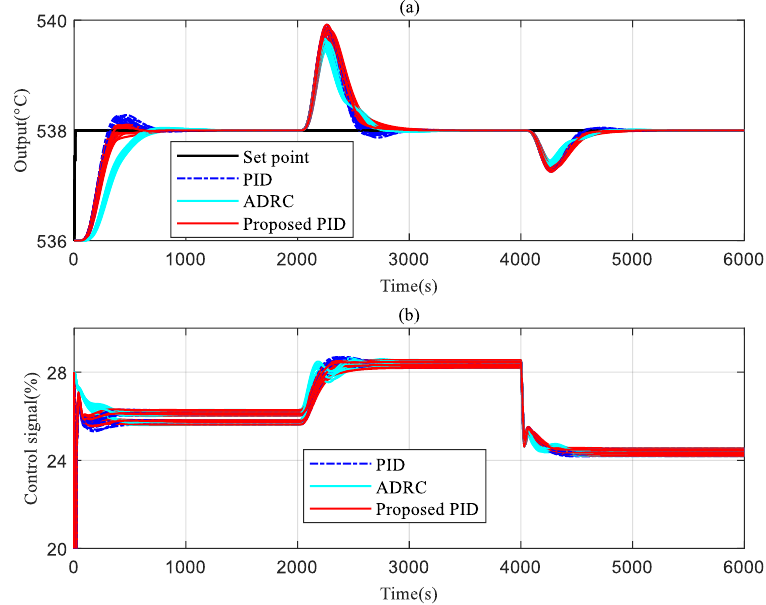
Figure 12. Control performance under an operating condition of 75% load with uncertainty in the SST system ( a ): outputs, ( b ): control signals.